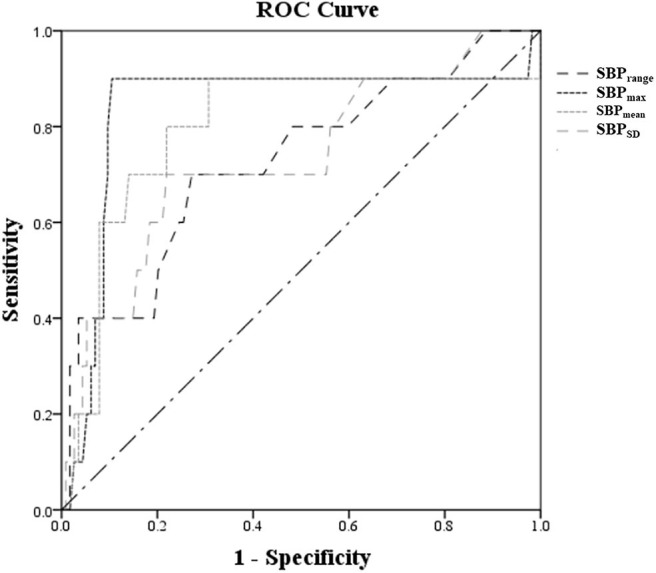
ROC curves of SBPmean, SBPmax, SBPrange, and SBPSD at the time of reperfusion after IVT to predict PH-2.